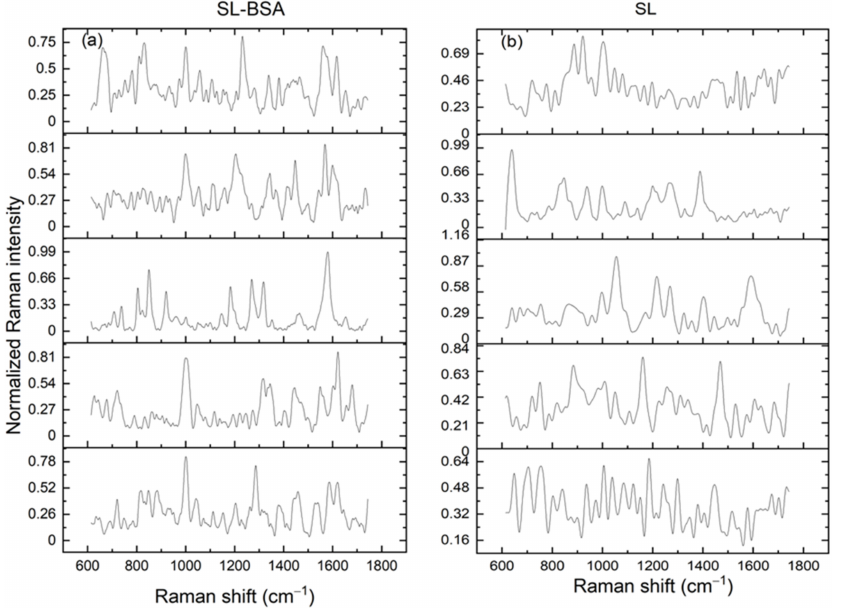
Figure 10. SERS spectra for ( a ) SL-BSA and ( b ) SL performed in different positions after smoothing, subtraction, and normalization. Acquisition time 3 s, wavelength 632.8 nm, power 50 microwatt. SERS spectra are recorded on the same substrate; each spectrum is the result of an average of three spectra taken from three positions. The raw data are presented in the Supplementary Materials (see Figure